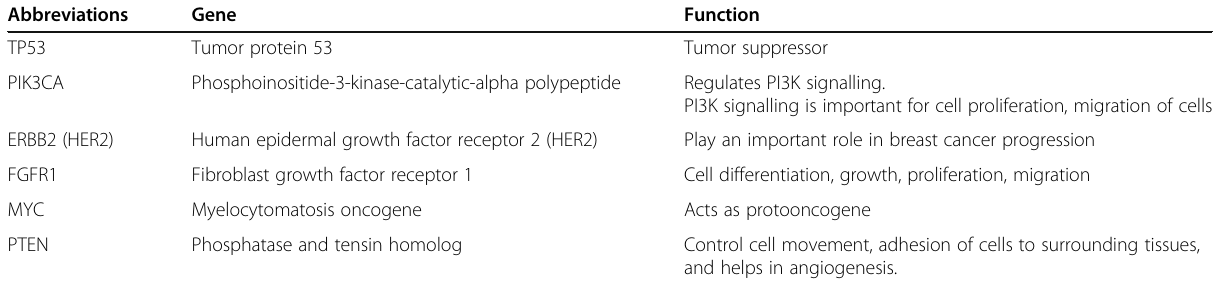
Table 1 Overexpressed genes in early breast